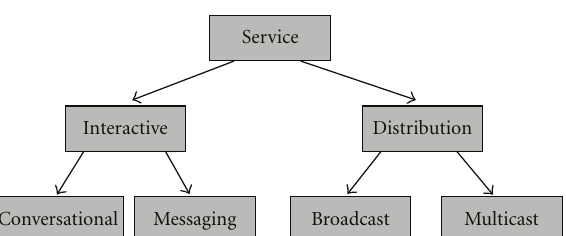
Figure 1: Article describing simplified ITS.